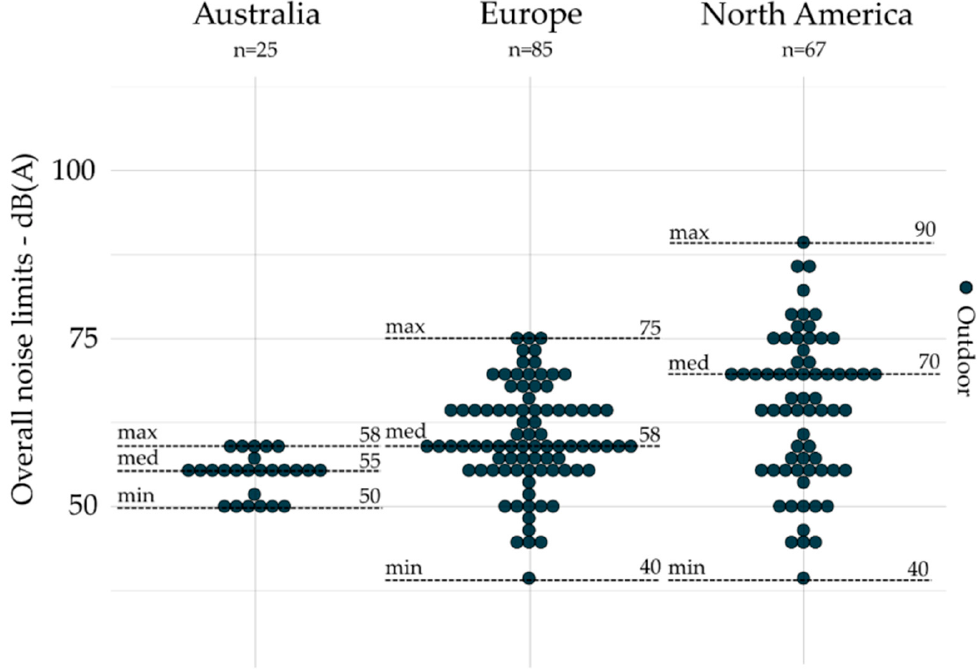
Figure 2. Overall indicators (without conversion by Brink’s method) for outdoors (all zones combined) grouped by geographic area ( n = 177).